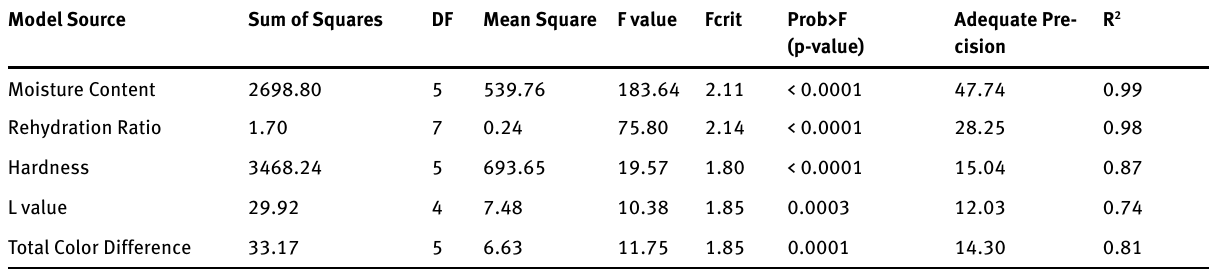
Table 2 Analysis of variance (ANOVA) for the regression models of moisture content, rehydration ratio, hardness, L value and total color difference of microwave-vacuum dried Saskatoon